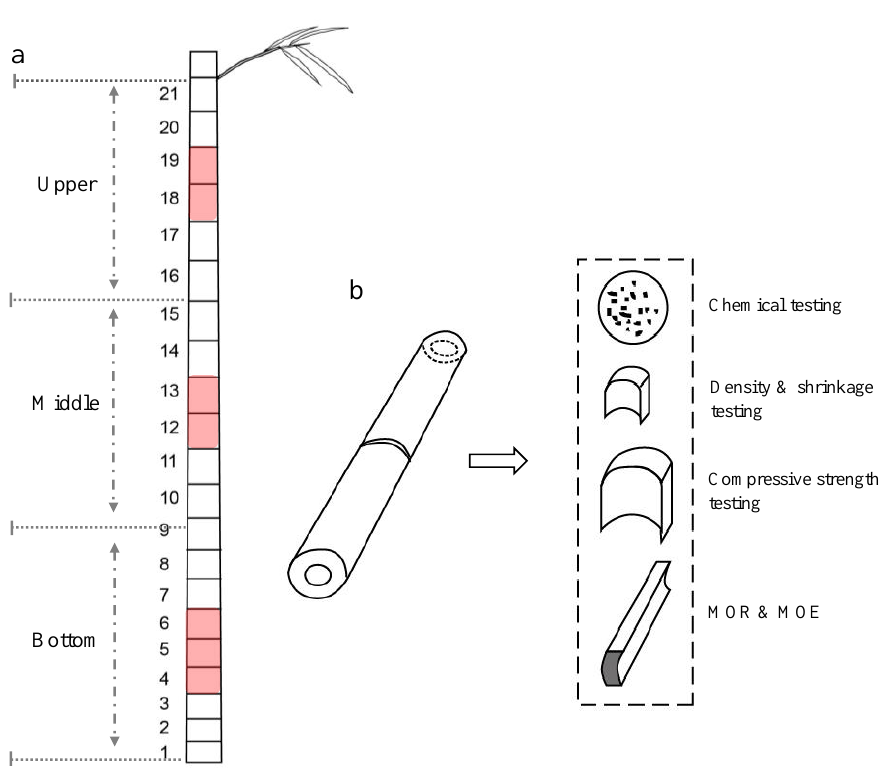
Figure 1. Schematic diagram of sample selection and making. ( a ) The location of the internode where the testing sample was cut. The internodes marked with pink are the parts which represent the bottom (the 4th–6th internodes), middle (the 12th–13th internodes), and upper (the 18th–19th internodes) parts of culm, respectively. ( b ) Sample making for chemical component and physical–mechanical testing.